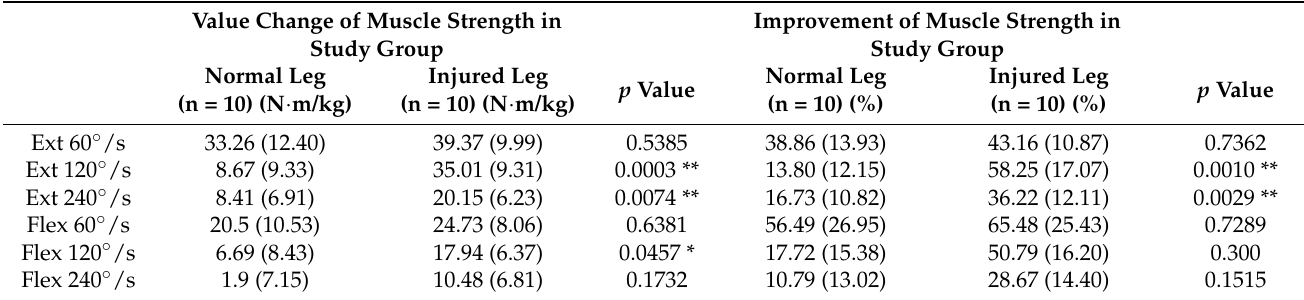
Table 4. Effects on the muscle strength change and improvement after training between the normal leg and PCL injured leg in the study group.